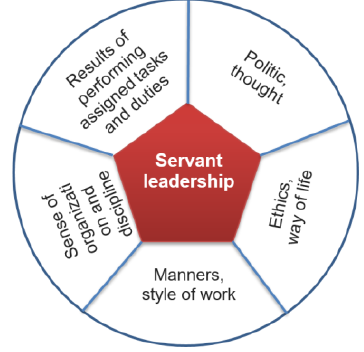
Figure 5. Leadership style model serving the public